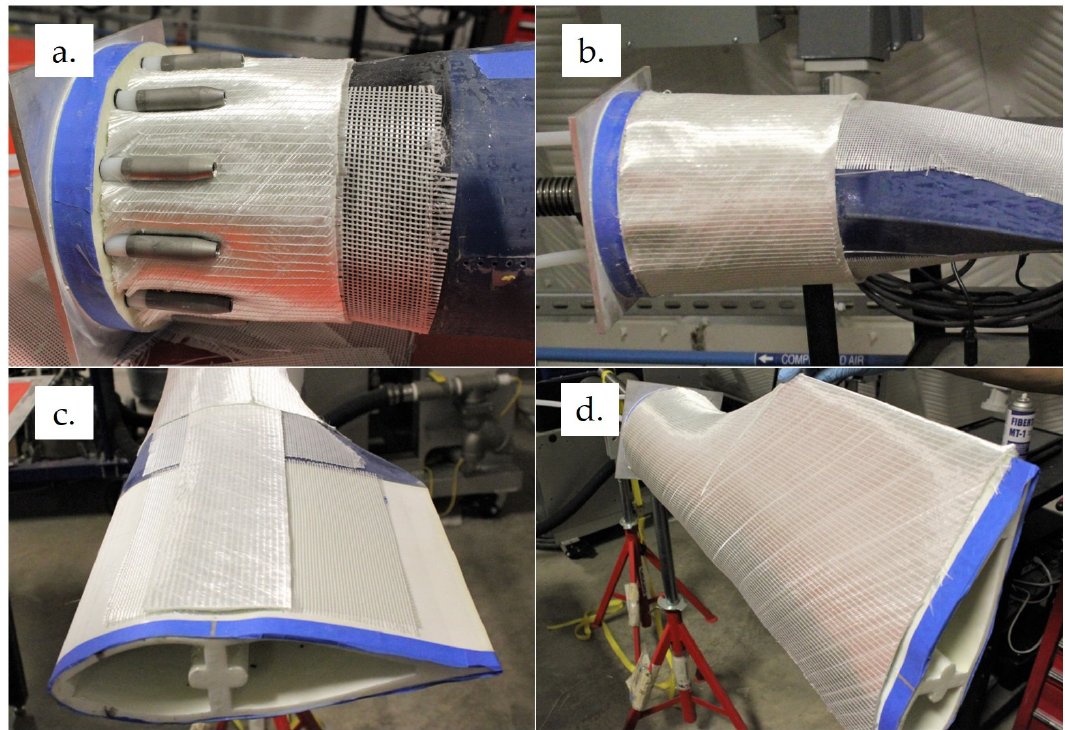
Figure 7. Showing the composite layup process with ( a ) the first half of the root plies and root inserts installed, ( b ) the second half of the root plies, ( c ) the spar caps, and ( d ) the final skin ply.